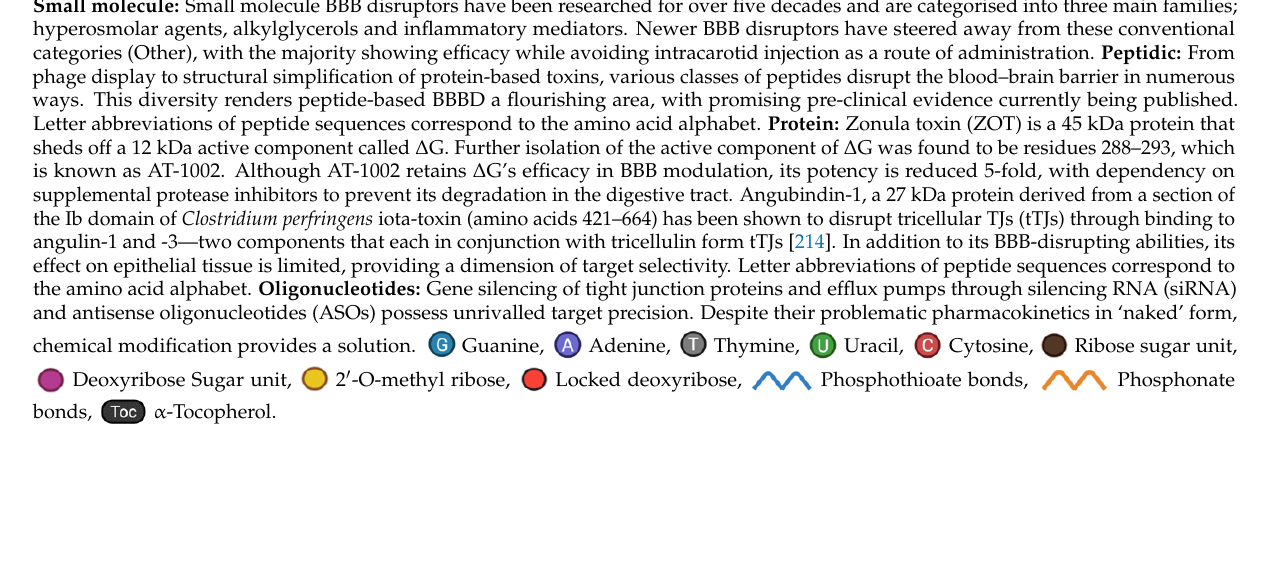
Table 5. Active NIH Clinical Trials in Therapeutic Blood–Brain Barrier Disruption (BBBD).